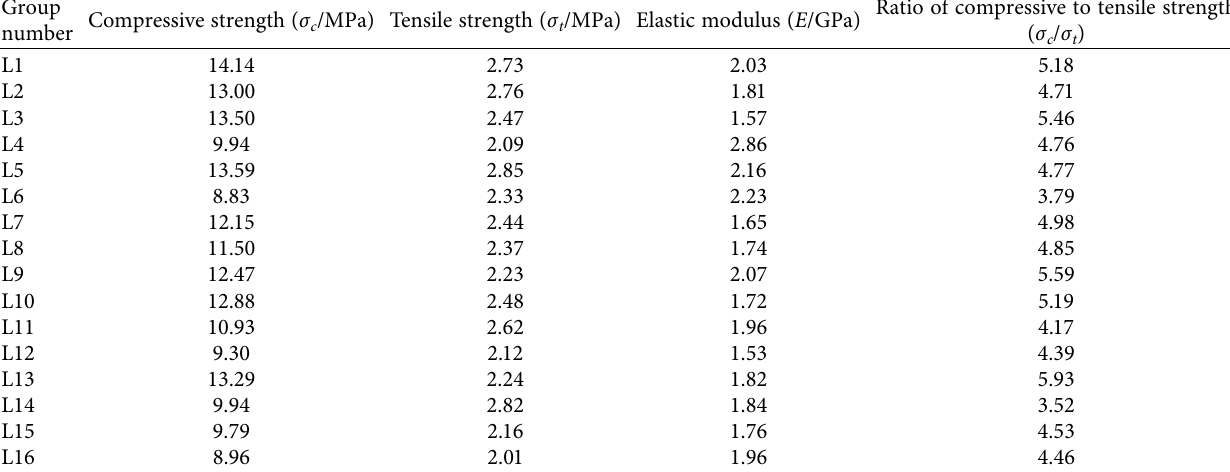
Table 4: Test results of orthogonal ratio covered by the study.